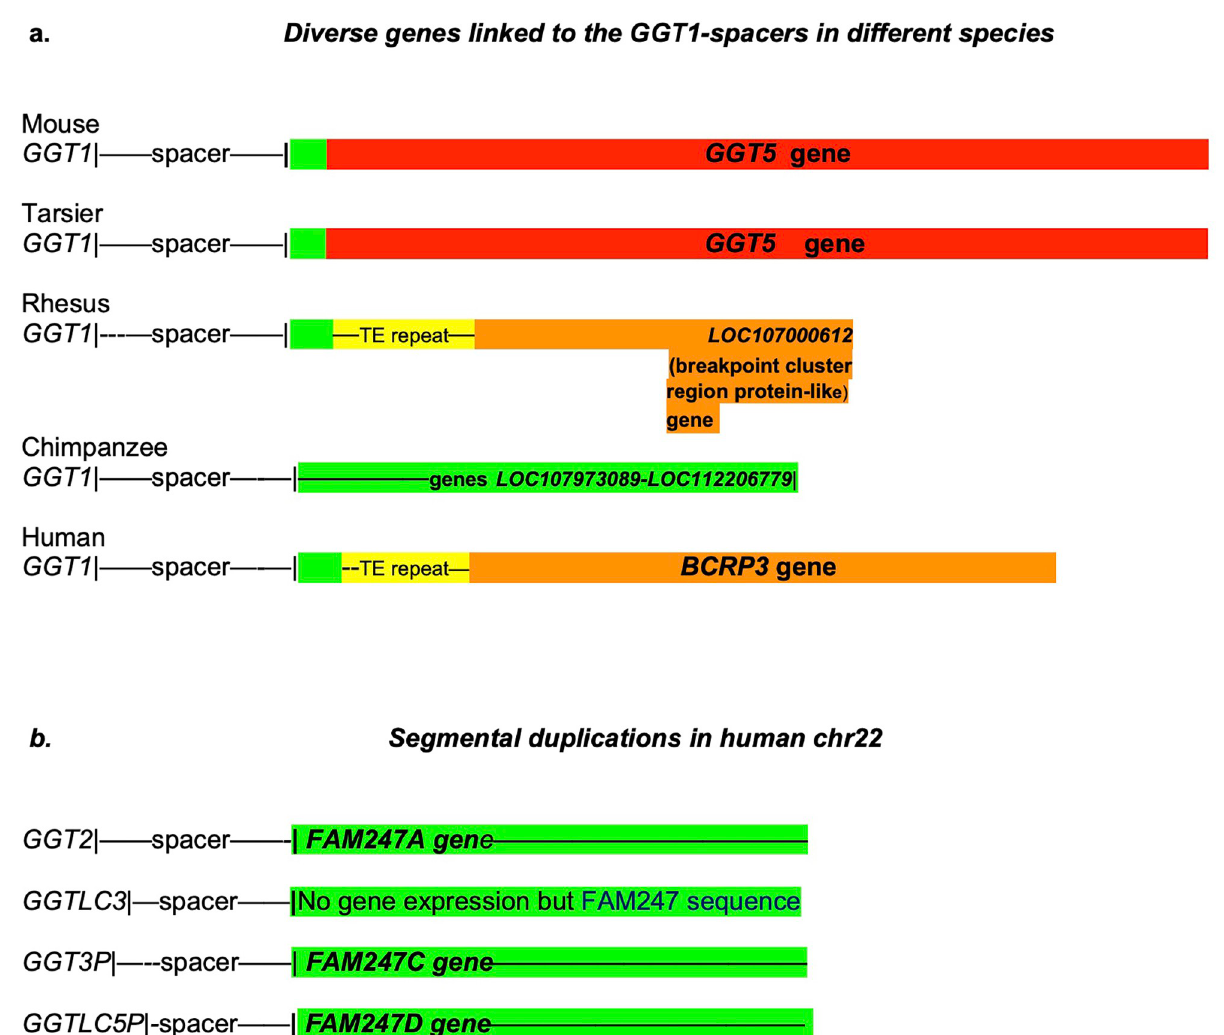
Fig 2. a . Diverse genes ( GGT5 , LOC107973089 , LOC112206779 , LOC107000612 , BCRP3 and FAM247) present in different species that stem from GGT1 -spacer sequence 3’ ends. The FAM247 sequence (highlighted in green) is partially or totally present in all genes and/or sequences linked to spacers. The yellow highlighted regions represent Alu/LINE TE tandem repeat arrays. The tan areas contain sequences of the BCR gene. b. Diagrammatic representation of the spacer sequences that lead to gene sequences, The green highlighted regions represent FAM247 sequences present in different genes that start close to the 3’ ends of spacers. GGT-related genes are highlighted in re and BCR-related in tan. There are FAM247 5’ end sequences present in some spacers, e.g., mouse and tarsier but not depicted in the diagram. b . The GGT -spacer- FAM247 gene family sequences present in different segmental duplications in human chr22 [14]. There appears to be no transcript expression from the FAM247 sequence associated with the GGTLC3 -spacer, although the sequence has 99.4% identity with lincRNA gene FAM2347A and contains the entire FAM247A sequence [15]. GGT family genes GGT2 , GGTLC3 , GGT3P , and GGTLC5P are protein or pseudogenes that developed at duplicated loci. 25bp and 354 bp of FAM247 are not in the GGT5 sequences of the mouse and Tarsier, respectively, and 34 and 36 base pairs of the 5’ end of FAM247 are not in the BCRP3 sequence GGT5 genes of Rhesus and humans,